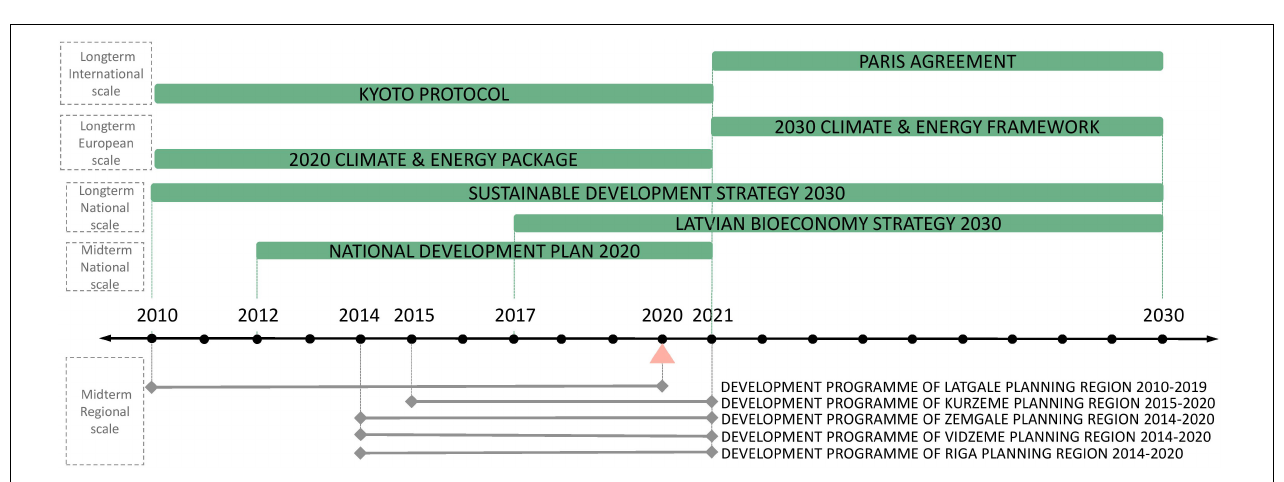
FIGURE 6 | The distribution of mineral soils, drained organic soils and organic soils in Latvia. Percentages indicate the proportional areal extent of each soil class within hexagons.